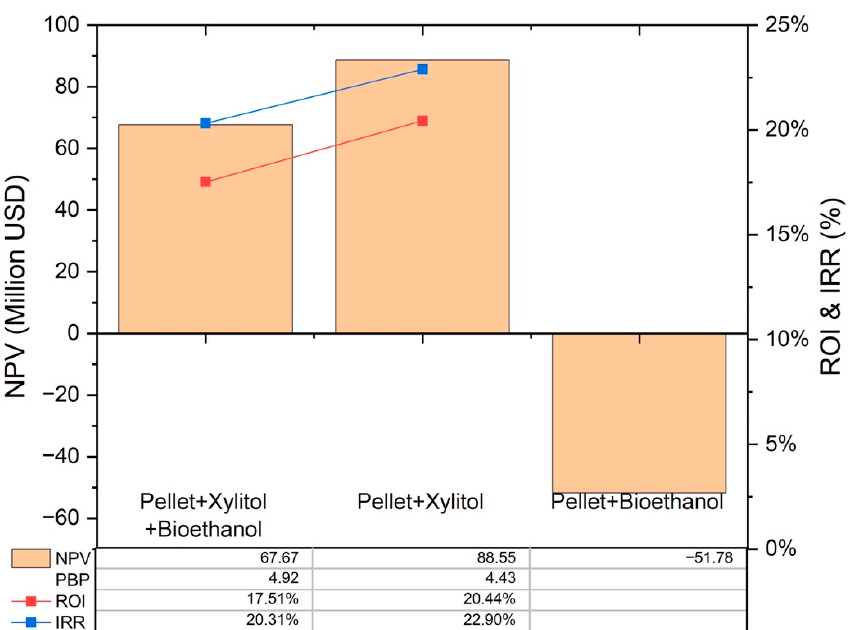
Figure 6. Economic profitability analysis of coproduction of pellet with xylitol and bioethanol, pellet with xylitol, and pellet with bioethanol at EFB splitting ratio of 30% to pellet production and MARR of 16%.